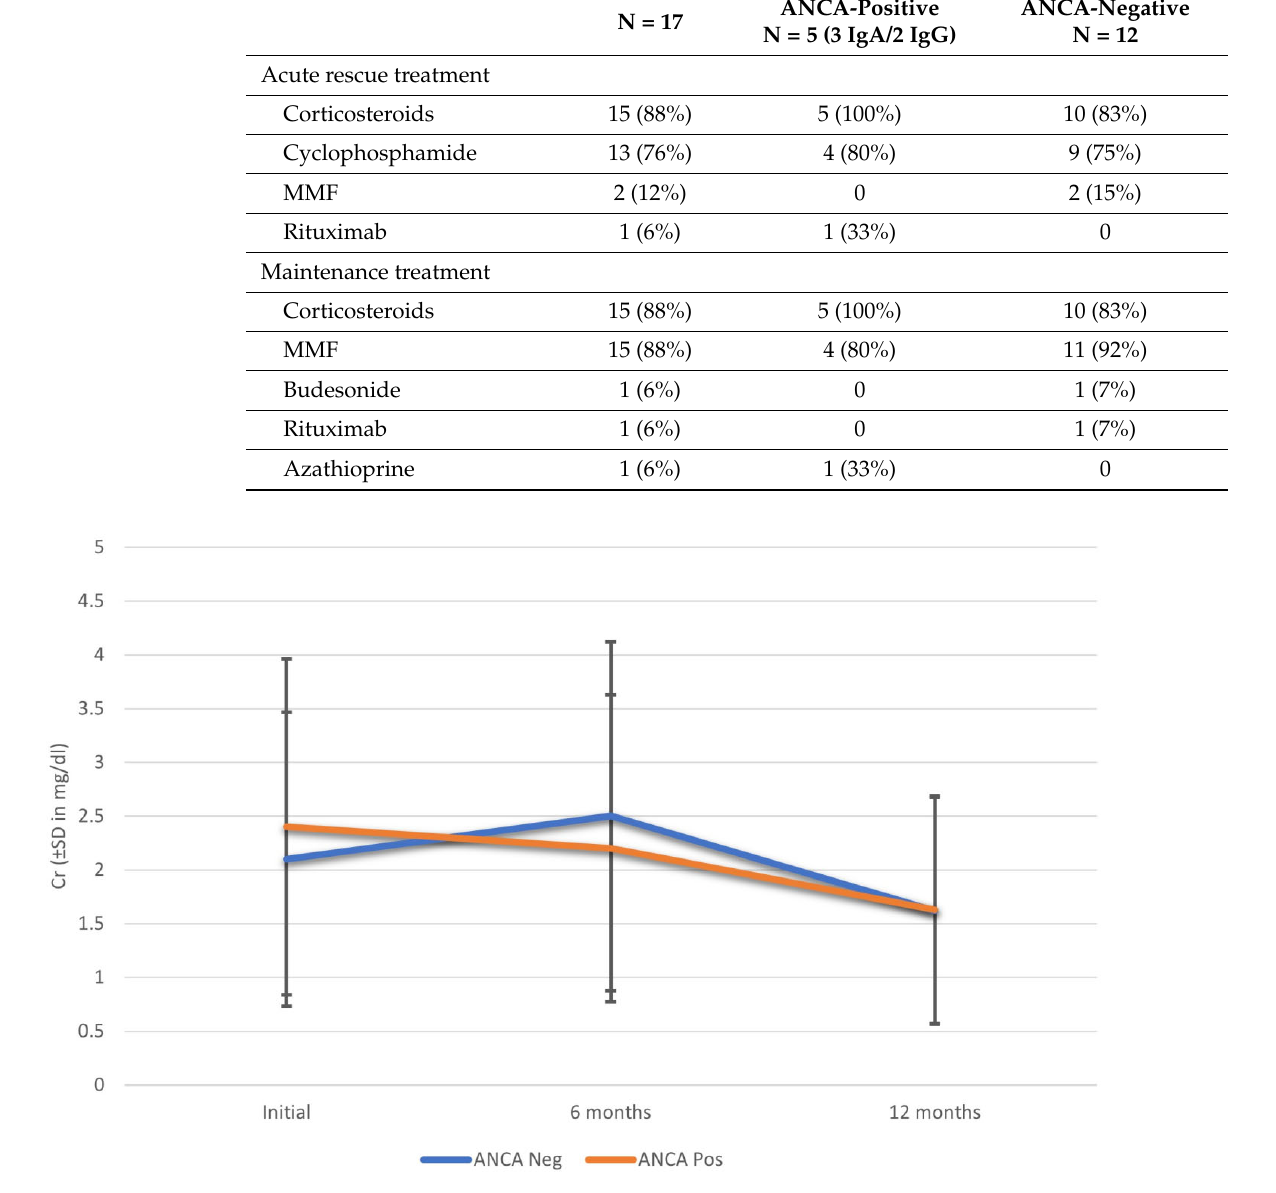
Figure 2. Renal evolution function with respect to creatinine in patients with IgA nephropathy and crescents according to the presence or absence of ANCA. Abbreviations: Cr—creatinine; SD—standard deviation.